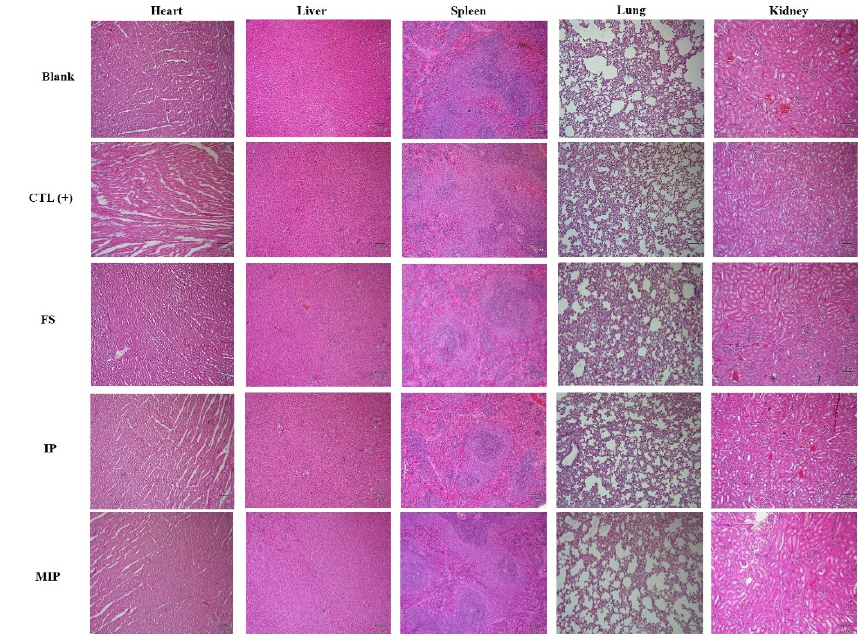
Figure 10. H&E staining of rat tissues after 14 day repletion in rats (40 × ; scale bar: 100 µ m). Blank: normal diet; CTL( + ): AIN-93G diet; FS: AIN-93G + 24 mg / kg FeSO 4 · 7H 2 O; IP: AIN-93G + 24 mg / kg commercial iron particles; MIP: AIN-93G + 24 mg / kg mesoporous iron particles.